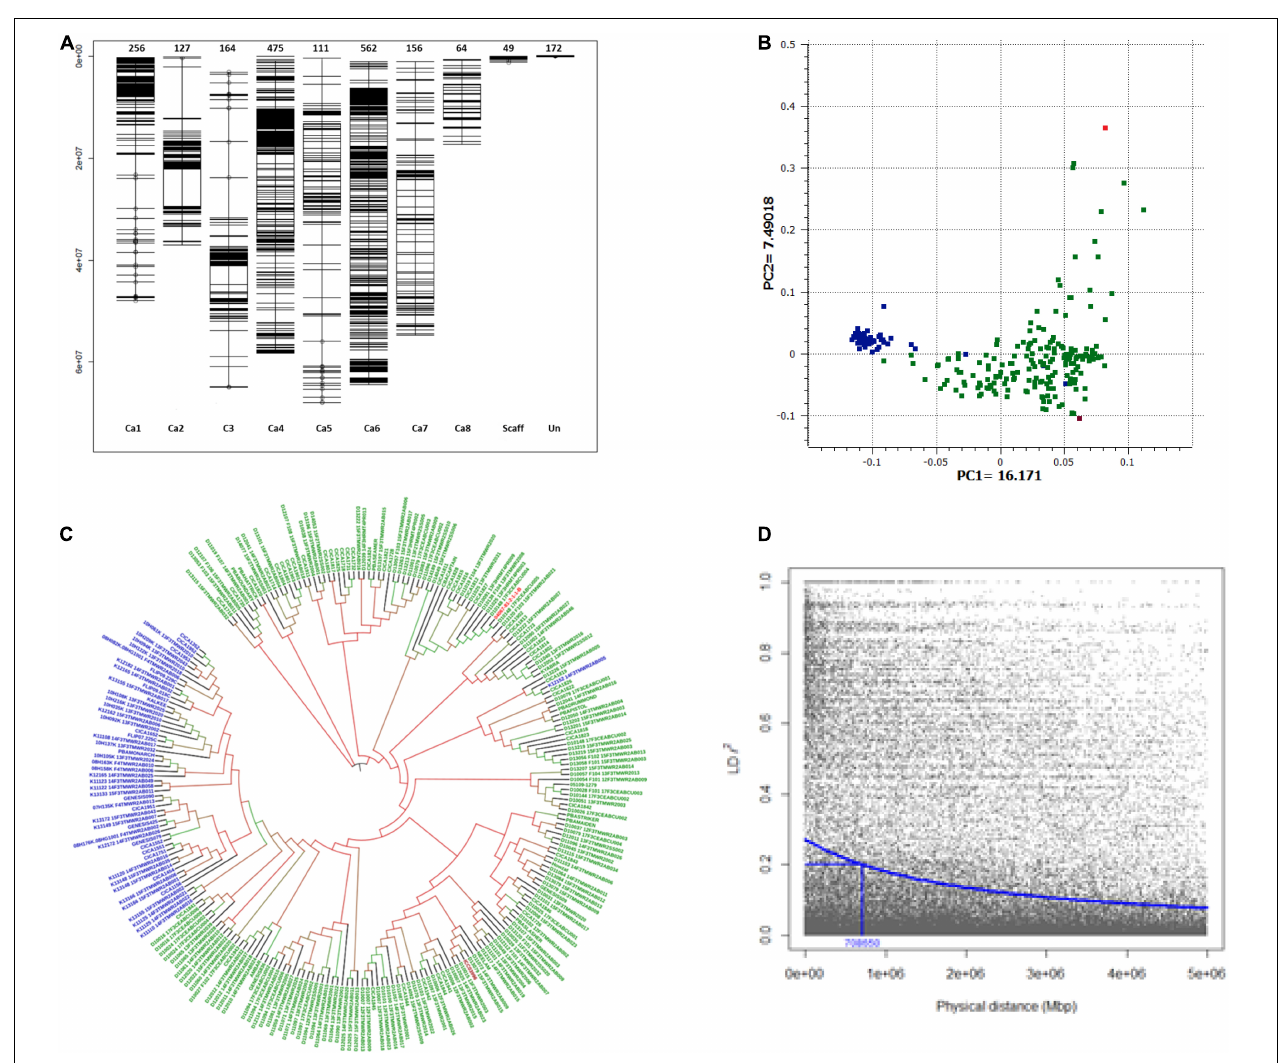
FIGURE 2 | Population structure and linkage disequilibrium (LD) decay plot of GWAS set of Australian chickpea genotypes. (A) Distribution and position of SNP markers on chickpea genome used to genotype GWAS set of 251 chickpea genotypes. Chromosomes: Ca1 to Ca8, Scaff: Scaffold, Un: Unlinked markers. (B) Principal component plot: A scatterplot of first two PCs corresponding to 251 desi and kabuli chickpea genotypes, blue: kabuli genotypes, green: desi genotypes, red: C. echinospermum interspecific line, maroon: landrace (ICC3996); (C) Neighbor-joining phylogenetic tree. (D) LD decay plot of all eight chickpea chromosomes. The squared correlation coefficient r 2 values (Y-axis) were plotted against the physical distance in megabase pairs (Mbp) (X-axis) using R Package Synbreed. LD decay ( r 2 = 0.2) occurs at approximately 0.70